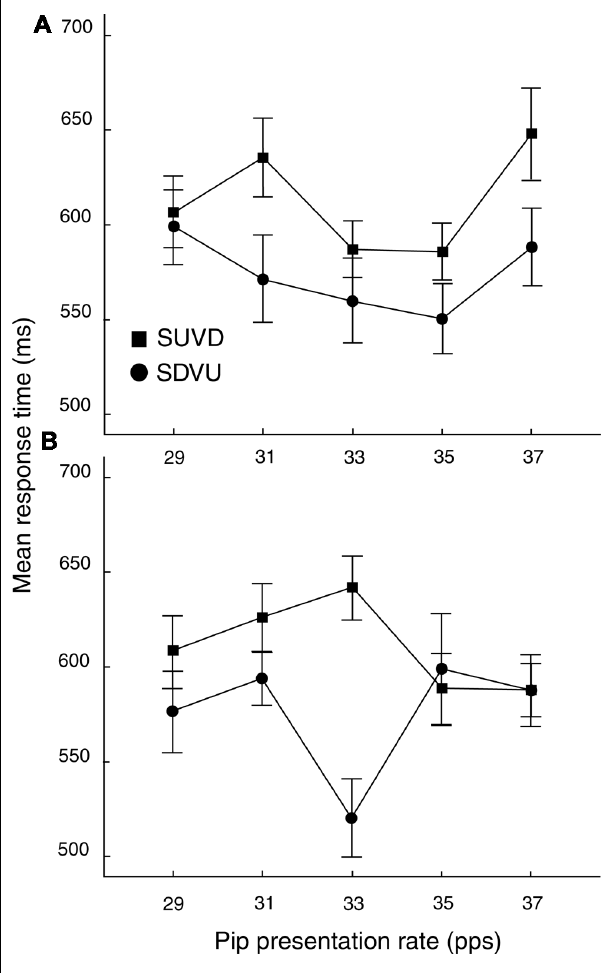
FIGURE 3 | Mean RTs ( ± 1 SEM) as a function of ISI, rate and target. (A) Rate by target interaction at 100 ms ISI. (B) Rate by target type interaction at 400 ms ISI. SDVU = spectral down – virtual up; SUVD = spectral up – virtual down. SEM values were computed using the procedure described by Loftus and Masson (1994).